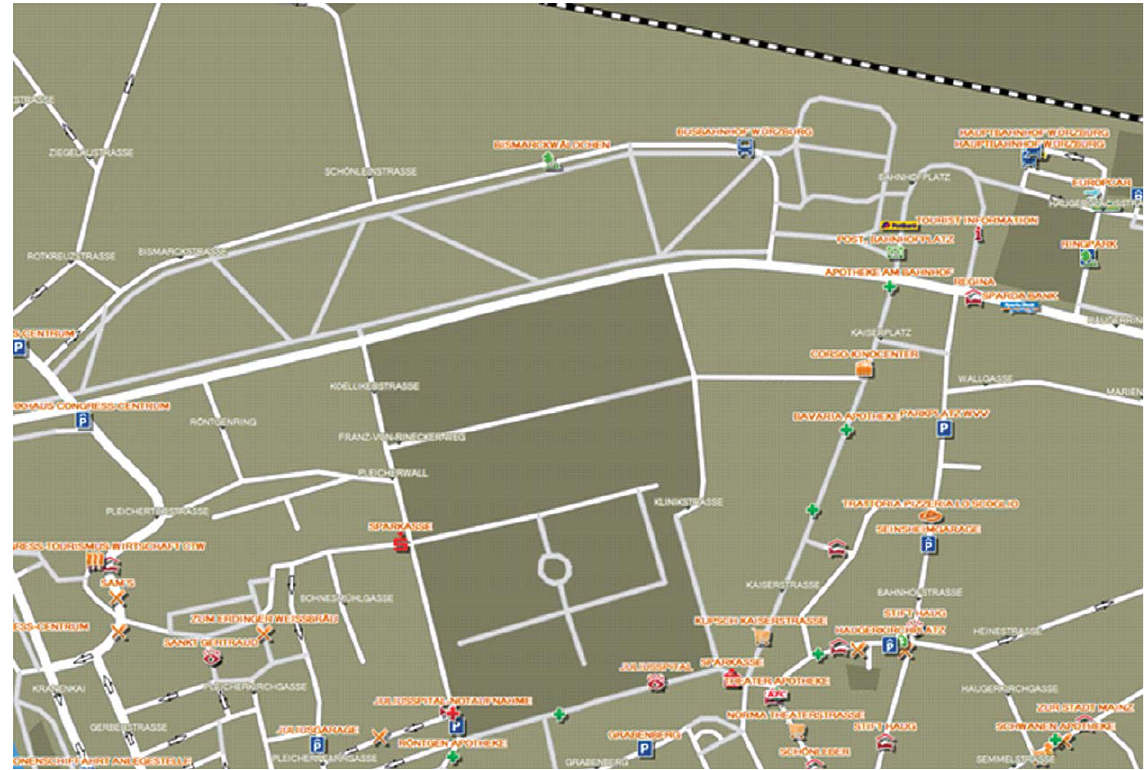
Fig. 9. Part of the test area W¨urzburg: map extended with pedetrian ways.